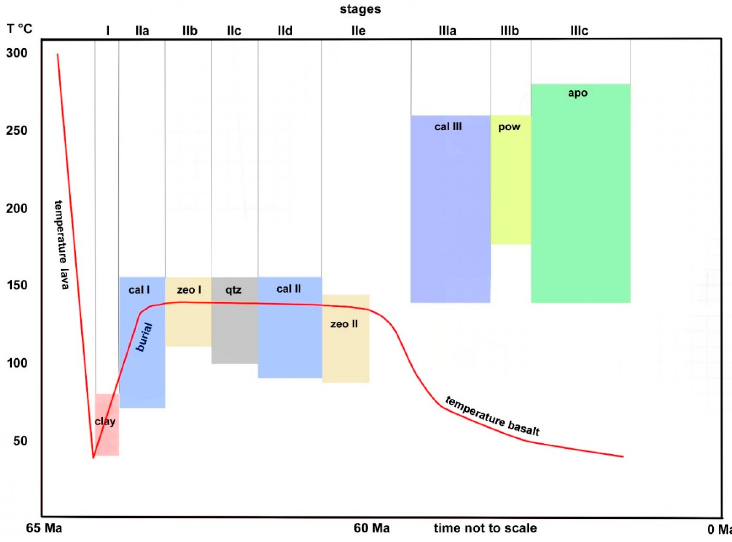
Figure 21. Multistage mineralization model for the big cavities in the core zone of the flow in Savda. (clay)—clay minerals; (cal)—calcite; (zeo I)—heulandite; stilbite, mordenite, and plagioclase; (qtz)— chalcedony/quartz; (zeo II)—heulandite and stilbite; (pow)—powellite; and (apo)—apophyllite. The red line represents the estimated temperature of the core zone of the flow, influenced by burial, thermal gradient, and erosion. The time near to the Earth’s surface (stage I) can be calculated with several years. The time for burial (stage II) is assumed for a period of approx. 5 Ma, up to the end of the volcanic activity of the DVP, starting with calcite I and ending with zeolite II. The remaining time for stage III amounts approx. 60